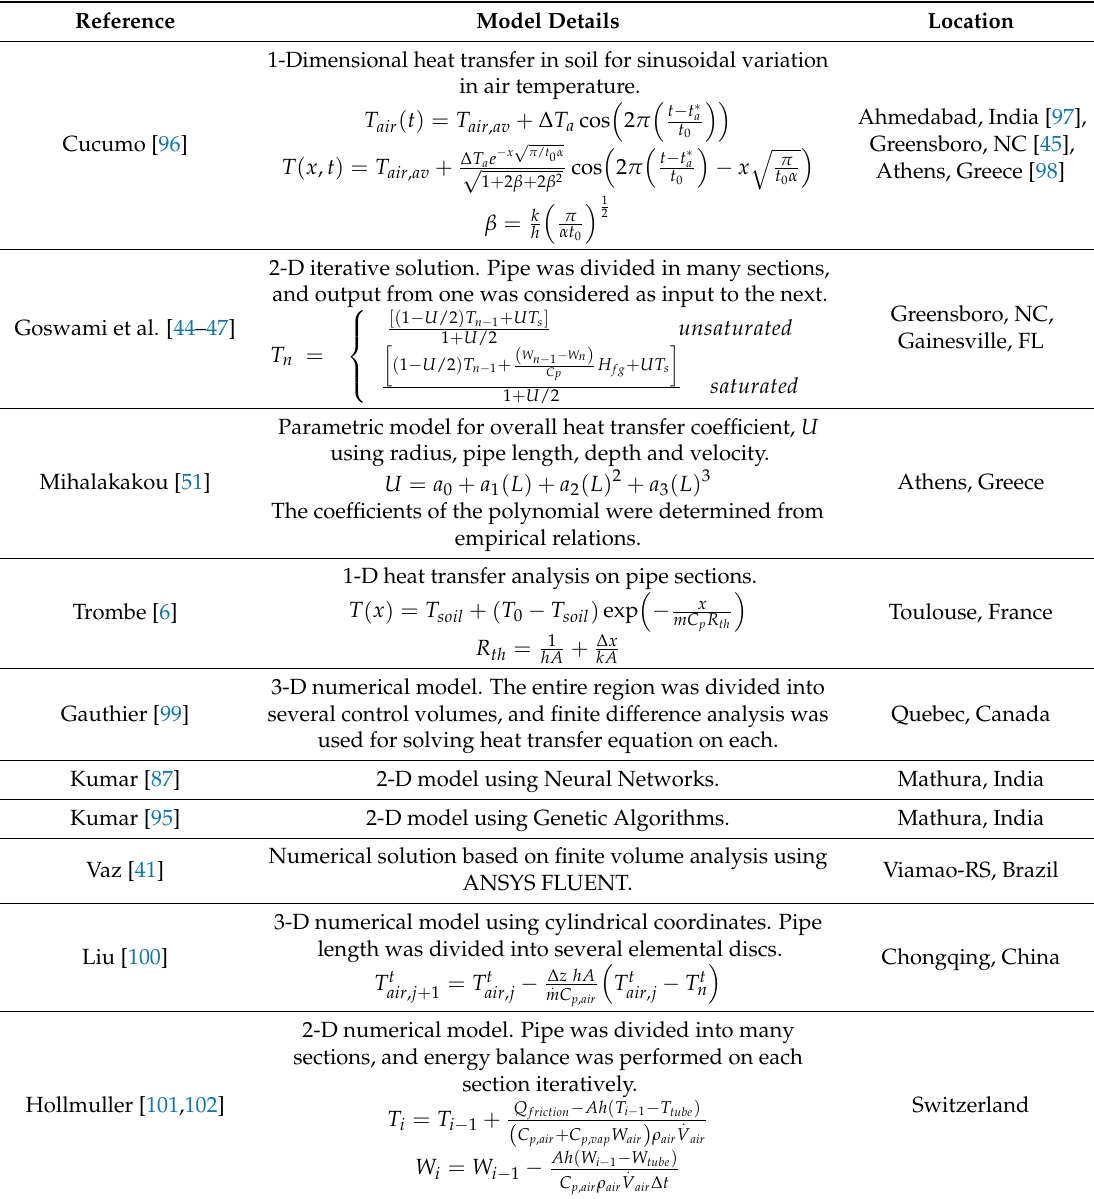
Table 1. Models used for EAHE